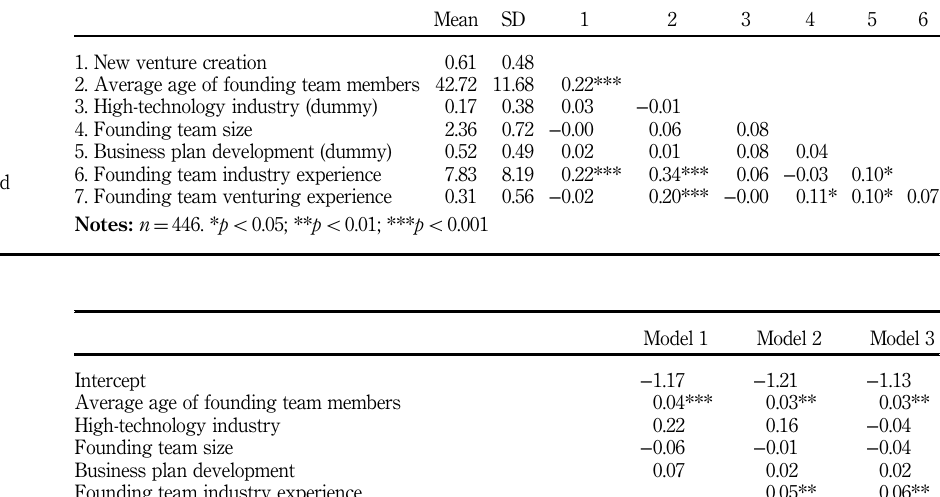
Table II. Logistic regressions with robust standard errors on new venture